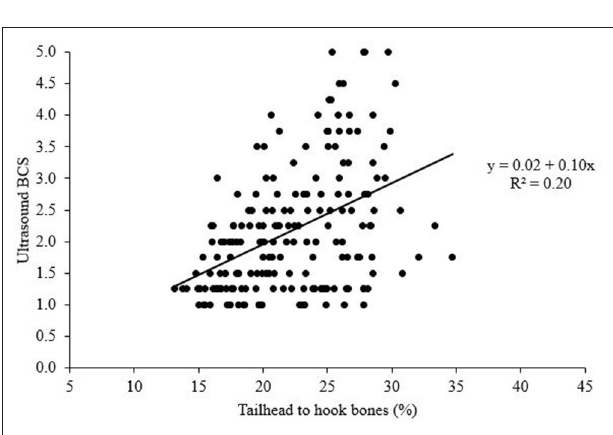
FIGURE 5 | Relationship between the tail head to hook bones width and ultrasound body condition score